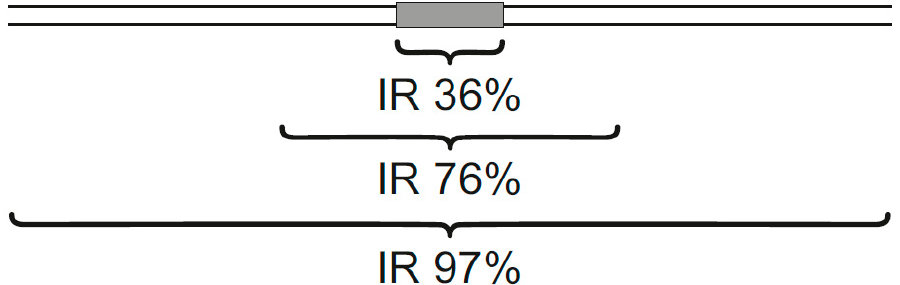
Figure 5. Frequencies and localization of inverted repeats in p53-ChIPed fragments, within a p53 double-stranded target, 20-bp around and 100-bp